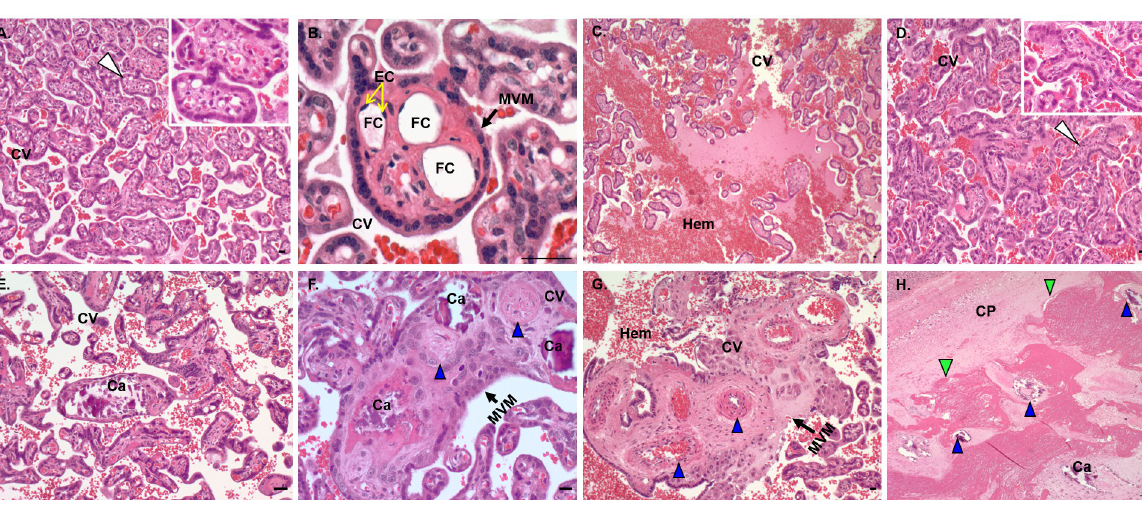
Fig 12. Placental histopathology in control dams and dams inoculated with ZIKV. ( A, B ) Control placenta with normal chorionic villi structure and mature vascular villi surrounded by intact MVM and containing numerous fetal capillaries (arrowhead, inset) and fetal capillaries lined with endothelial cells ( B ). ( C, H ) Placenta from ZIKV inoculated dams showed multiple changes in the villi and vascular structure such as immature and avascular villi ( D ; arrowhead, inset), hemorrhage ( C, G ), fetal capillary thickening, thrombosis and mineralization ( F, G, H ; blue arrowhead), disruption of MVM ( F, G ) and fibrin deposits (green arrowhead) surrounding fetal vessels undergoing thrombosis and mineralization ( E, F, H ). Fig C, H are from Dam 1E placenta and Fig D, E, F and G are from Dam 3E placenta. CV, chorionic villi; EC, endothelial cells; FC, fetal capillaries; Hem, hemorrhage; MVM, microvillous plasma membrane; Ca, calcification; CP, chorionic plate. (Scale bar = 50 μ m).